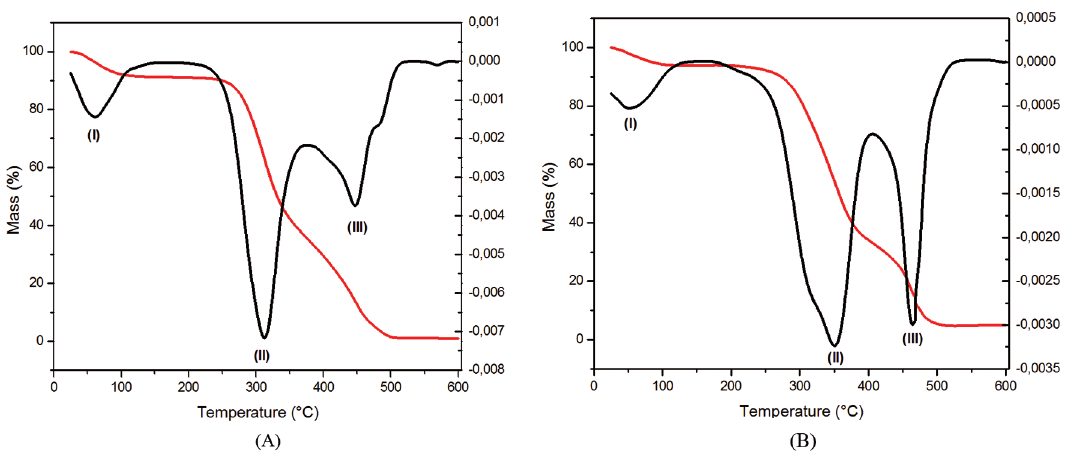
Figure 6: TGA and DTG curves of coconut fibers (A) and sisal fibers (B), heating rate: 10 °C. min -1 under nitrogen atmosphere flow of 50 mL.min -1 Table 2: Values of the initial temperature (T I, II and III of coconut fibers and sisal